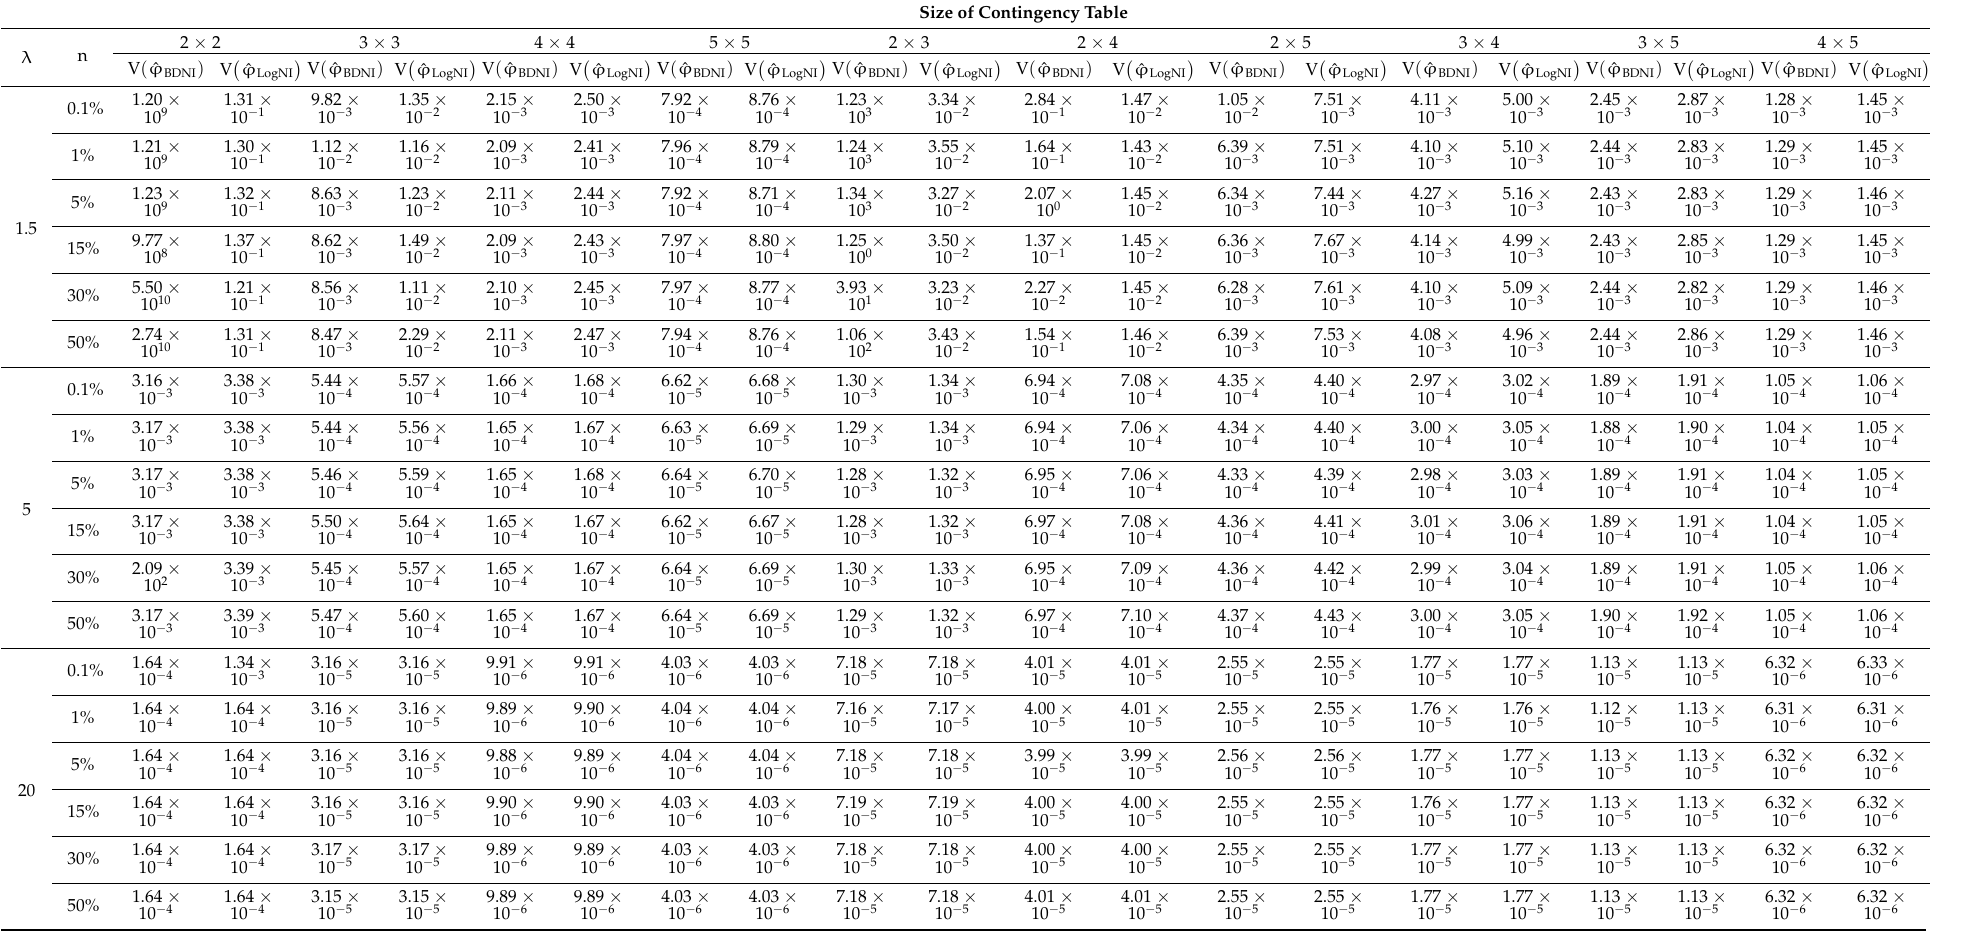
Table 3. Asymptotic variances of ˆ ϕ LogNI and ˆ ϕ BDNI for varying dimensions and λ s of simulated contingency